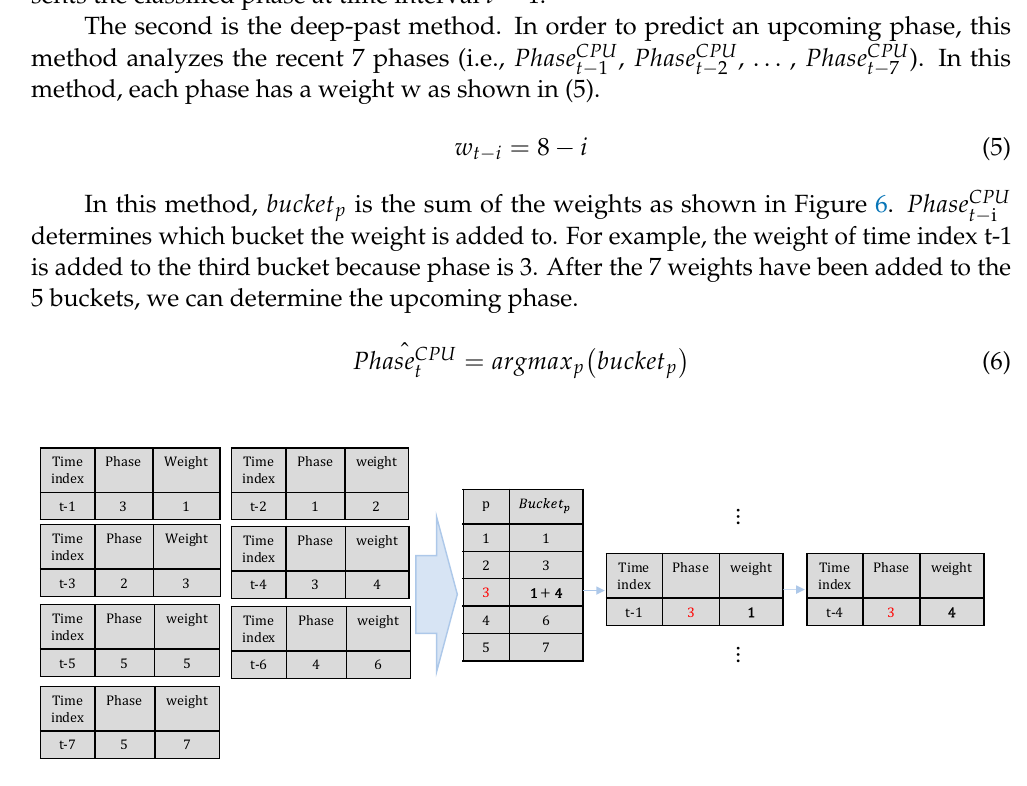
Figure 6. Example of phases, weights, and buckets in the deep-past method.